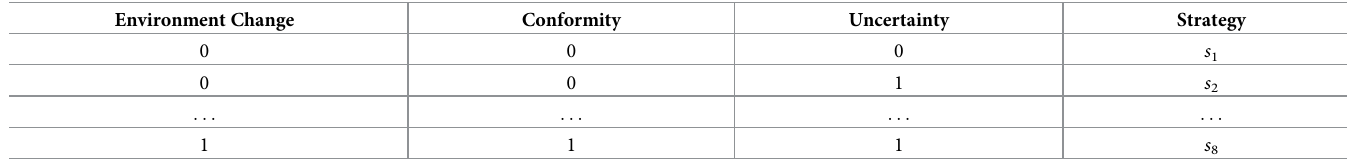
Table 2. Possible states of the environment and their strategy assignments that can take one of the strategies as: Individual learning, success-based or conformist. Environment